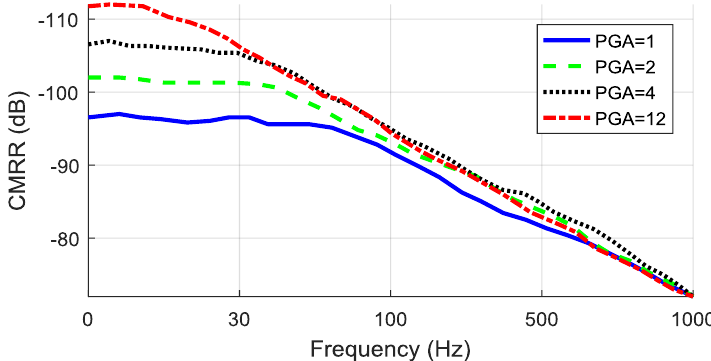
Figure 13. Common-mode rejection ratio (CMRR) measurement results.